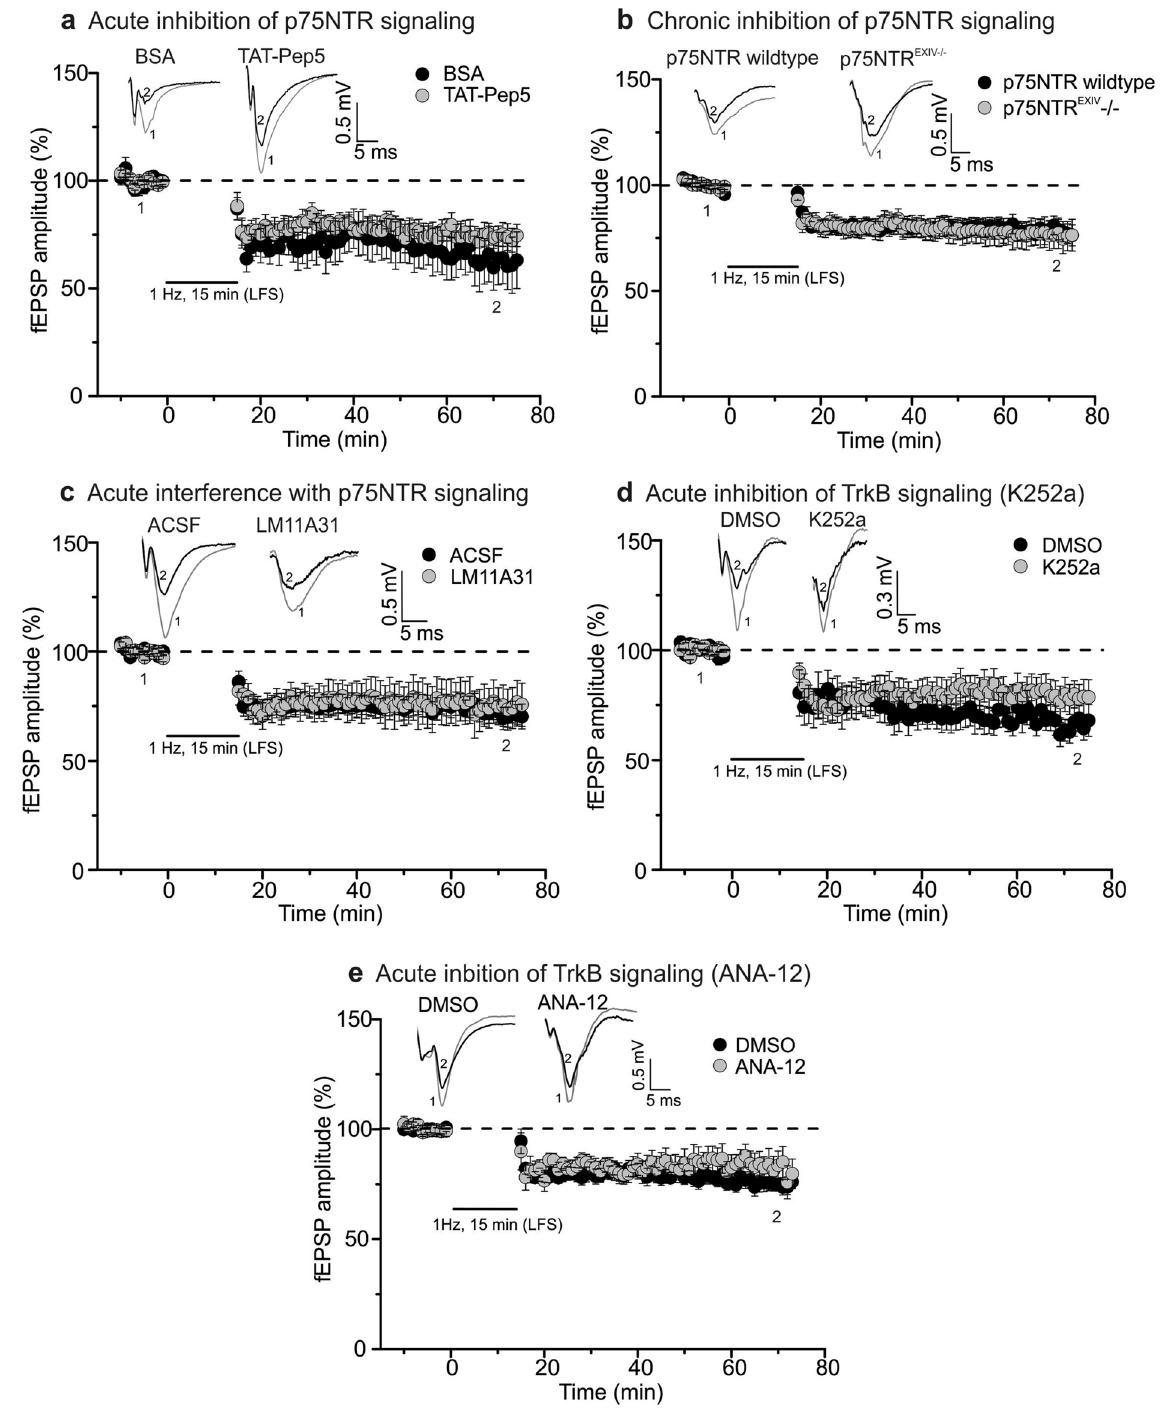
Figure 2. LTD at MF synapses is not mediated via p75NTR or TrkB receptor signaling. ( a ), ( c ) and ( d ) MF LTD is not impaired in the presence of bath applied TAT-Pep5 (1 µM, a ), LM11A31 (100 nM, c ) or K252a (200 nM, d ) in comparison to the respective solvent controls (filled circle: BSA ( a , n = 8/N = 6), ACSF ( c , n = 16/N = 12) and DMSO ( d , n = 12/N = 6); filled gray circle: TAT-Pep5 ( a , n = 11/N = 10), LM11A31 ( c , n = 11/N = 6) and K252a ( d , n = 9/N = 5)). b) Recordings in slices of p75NTR EXIV−/− mice displayed no influence of p75NTR chronic deficiency on LTD magnitudes at MF synapses (filled circle: p75NTR wildtype (n = 8/N = 5); filled gray circle: p75NTR EXIV−/− (n = 12/N = 7)). ( e ) Unaltered MF LTD in the presence of bath applied ANA-12 (20 µM), in comparison to the respective solvent control (filled circle: DMSO (n = 16/N = 11); filled gray circle: ANA-12 ( e , n = 11/N = 6). The figure insets show representative averaged original fEPSP traces. For all MF-LTD experiments, “1” indicates mean fEPSP amplitudes of first 10 min of baseline and “2” depicts mean fEPSP amplitudes between 55 and 60 min after induction of LTD. Data expressed as mean ± SEM. Corresponding scale bars are shown as